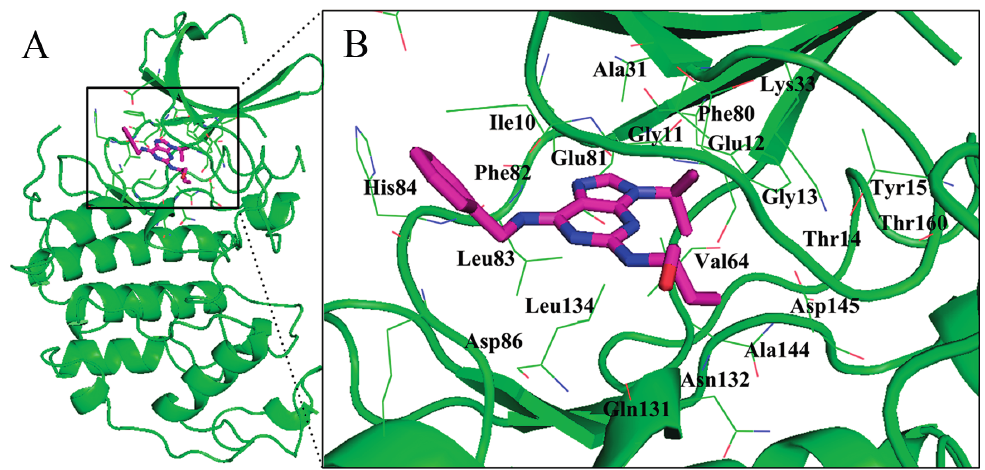
Figure 4. Position of competitive binding site. Panel ( A ) displays the competitive binding site of the monomer CDK2 with inhibitor roscovitine (coordinates 2A4L); the detailed information of amino acids in this cavity is shown in panel ( B ).